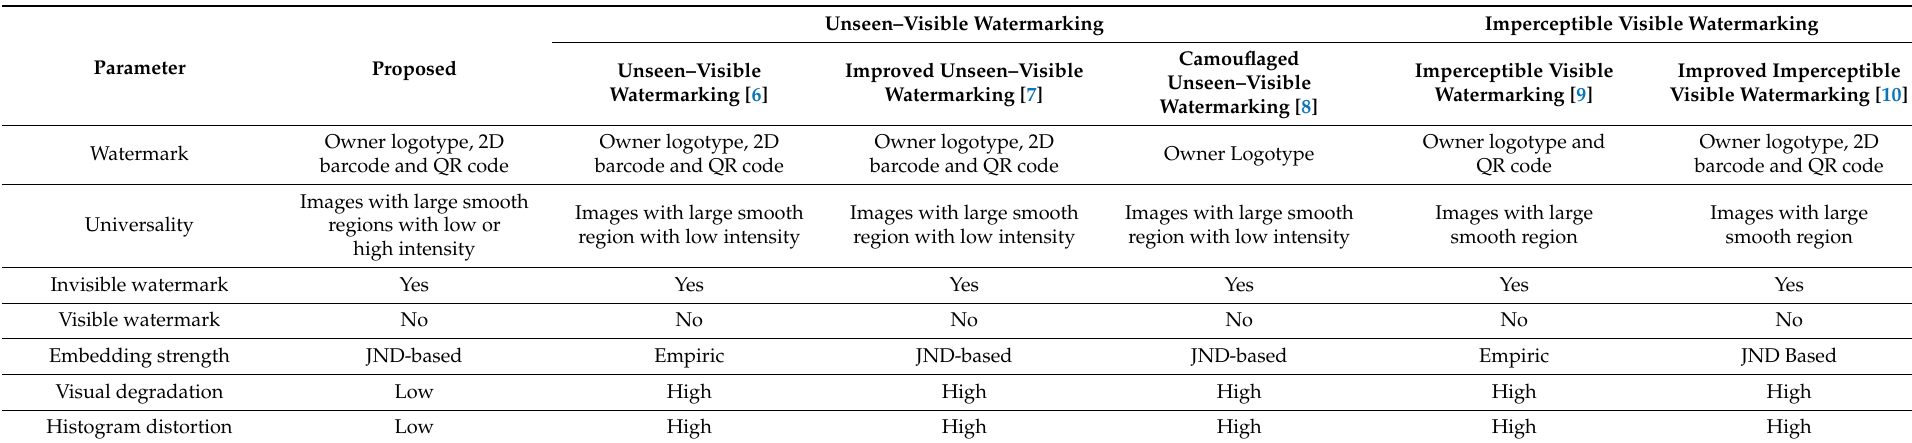
Table 5. Global comparison among previously reported algorithms and the